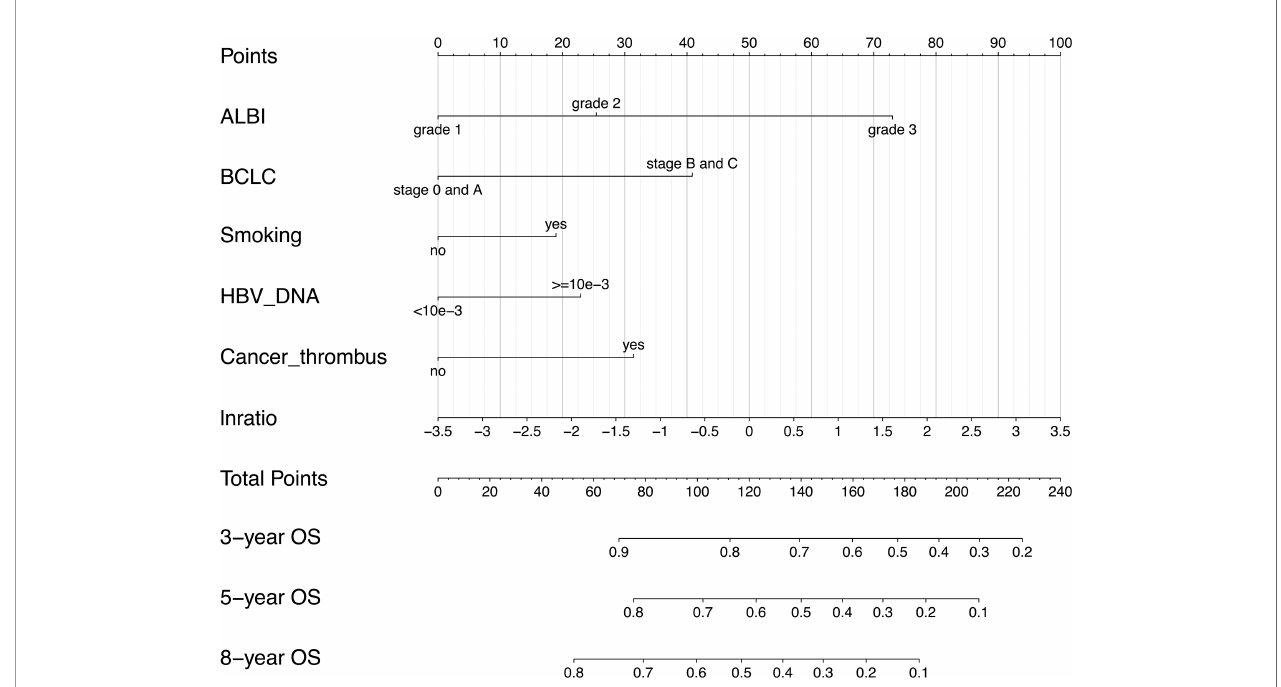
FIGURE 3 | Postoperative prognostic nomogram for patients with hepatocellular carcinoma. ALBI, albumin – bilirubin; BCLC, Barcelona Clinic Liver Cancer; lnratio, the natural logarithm of aspartate transaminase/alanine transaminase ratio.